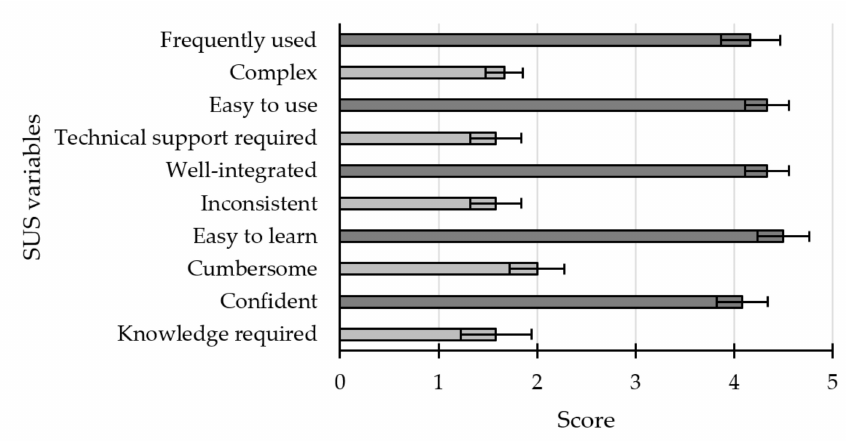
Figure 5. Average results ( ± standard error) reported by participants in each of the subdimensions of the system usability scale (SUS). The dark grey scales refer to positive items, while the light grey scales refer to negative